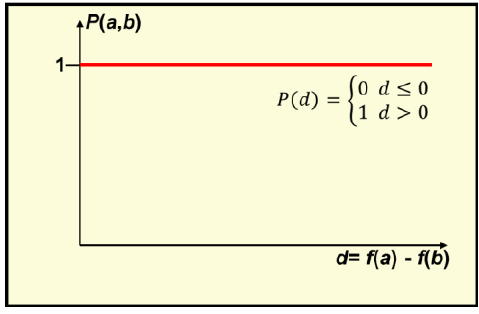
95 Table 2. Weight for subcriteria [46]. Criteria